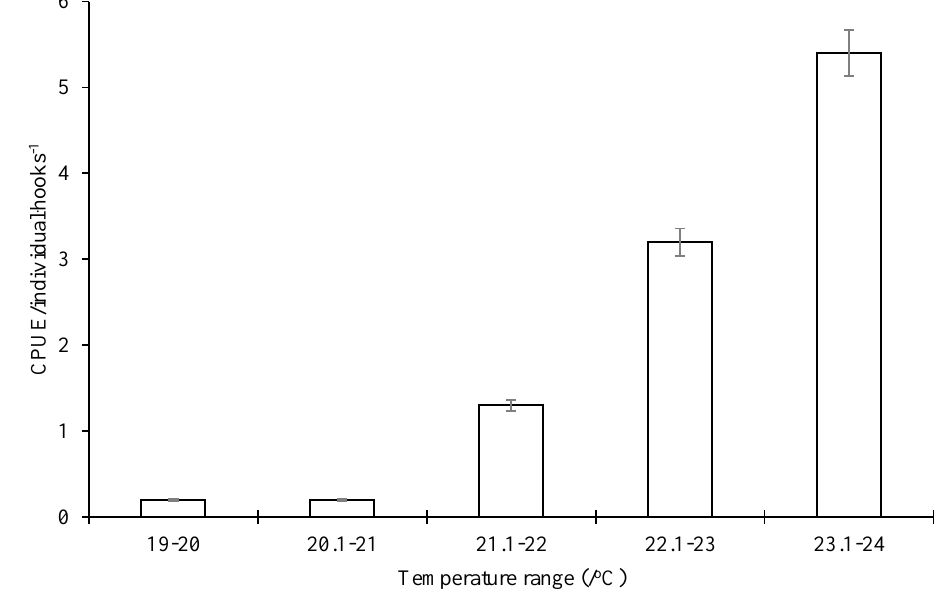
Figure 9. CPUE 2j of Acanthocybium solandri in different temperature ranges.